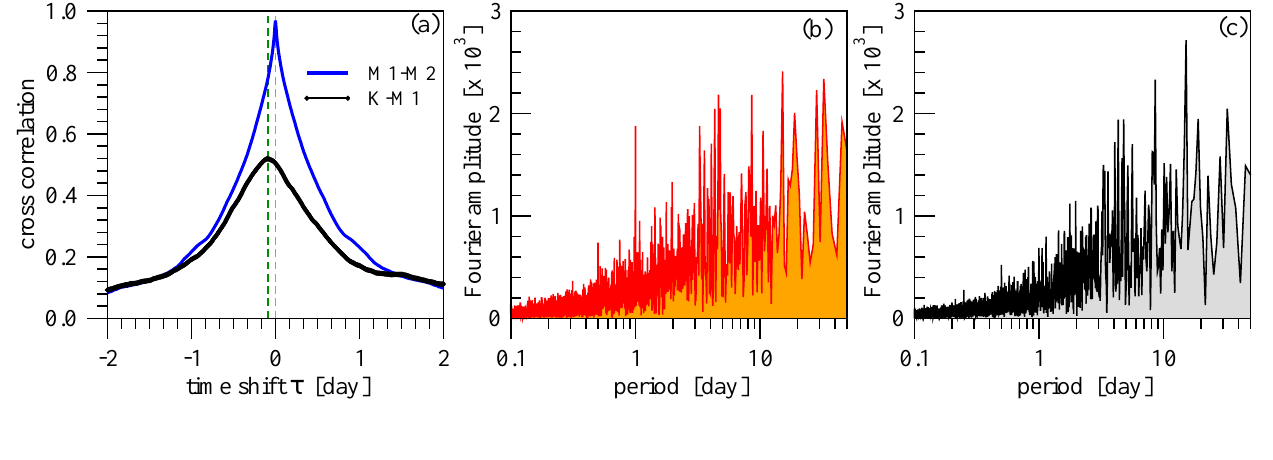
Figure 3. (a) Cross-correlation function [see Equation (2)] for the power records K and M 1 (black) and M 1 and M 2 (blue). Vertical dashed lines indicate the peak maxima. (b) Normalized Fourier amplitudes for the power record K . (c) The same for the integrated series shown in Figure